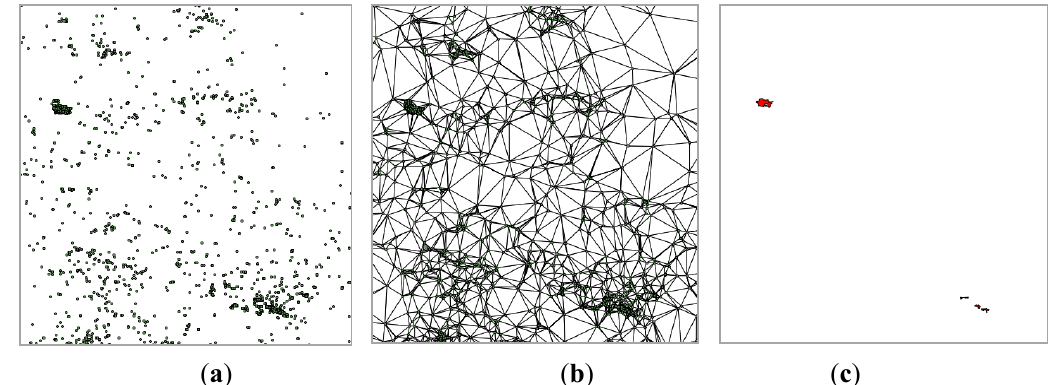
Figure 8. Member activity area creation: ( a ) nodes of contributor, ( b ) triangulation, ( c ) edge-distance-filtering (final activity areas